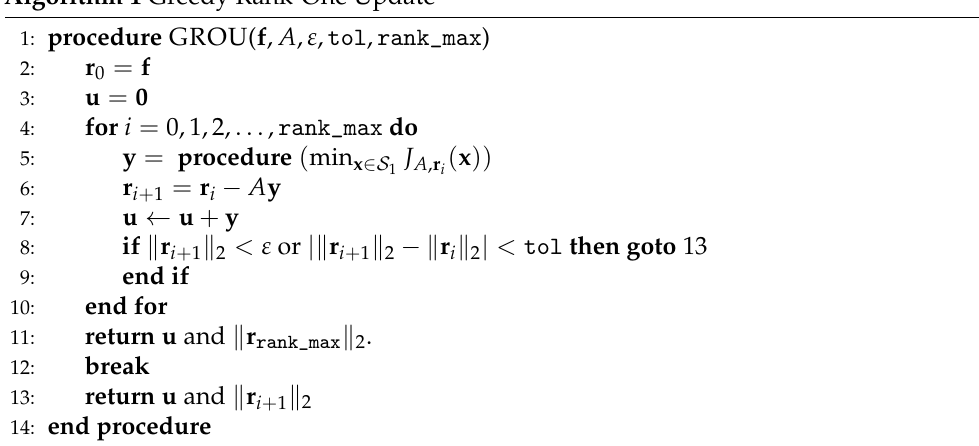
Algorithm 1 Greedy Rank-One